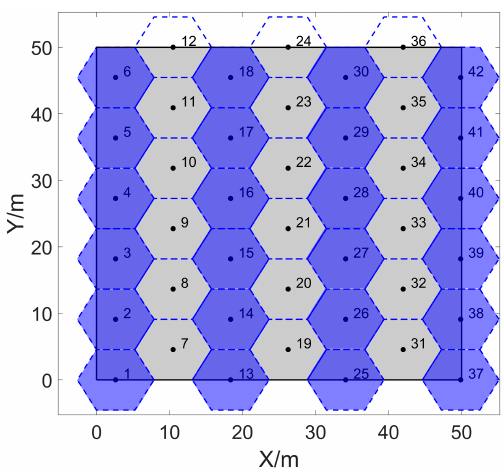
Figure 3. Stacking the two-dimensional area seamlessly with 42 cellular grids. The length and width of the area are both 50 m, and the radius of each cellular grid is 5.25 m .